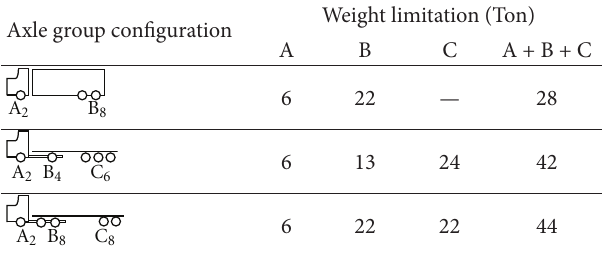
T 1: Axle group con�gurations and weight limitations of most popular